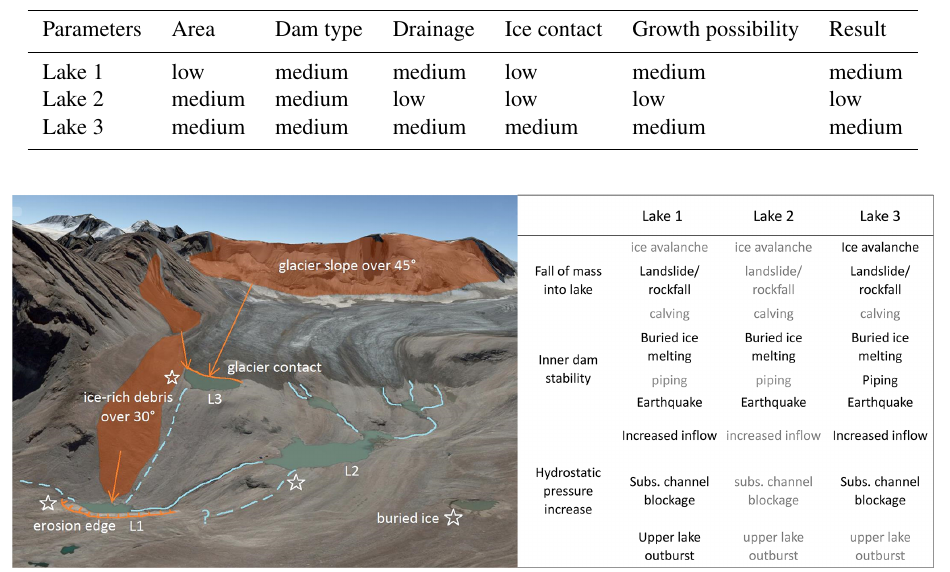
Table 5. The resulting lakes’ inherent susceptibility to outburst.